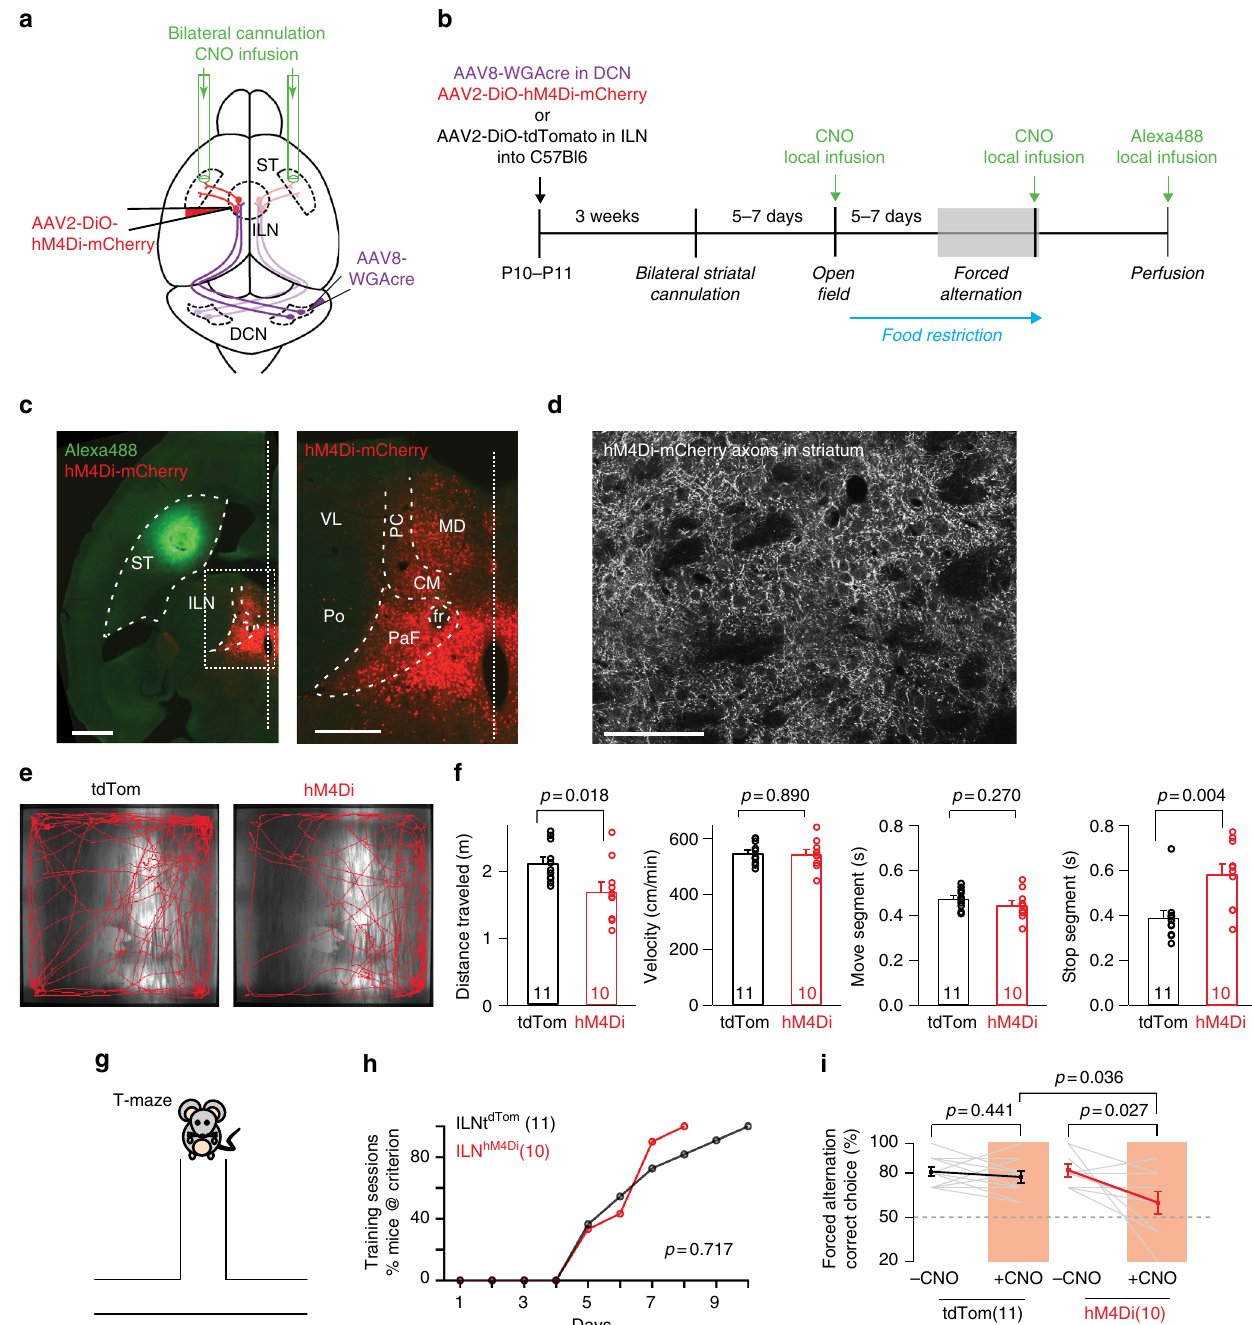
Fig. 7 Striatum-speci fi c silencing of cerebello-striatal connectivity. a Stereotaxic injection scheme for local silencing experiments. For local infusion of CNO, mice are bilaterally cannulated in the dorsal striatum. b Timeline and analysis scheme of local silencing experiments. See text and methods for details. c Overview (left) and ILN enlargement (right) of dorsal striatum and thalamic nuclei in mice at the end of the experiment. Cells expressing hM4Di- mCherry fusion protein (red) are observed in parafascicular nucleus (PaF) and centromedial nucleus (CM). The spread of Alexa488 dextran applied through the cannula in the striatum is shown in green ( N = 11 mice). d High magni fi cation image of hM4Di-mCherry positive axons in the dorsal striatum. This reveals ef fi cient transport of the hM4Di-mCherry fusion protein into the thalamo-striatal axons. e Example open fi eld tracks of control ILN tdTom (tdTom) and ILN hM4Di (hM4Di) expressing mice (targeted with intersectional viral approach described above). Mice were locally infused with CNO (30 μ M, 800 nl/side) 35 min before the test. f Quanti fi cation of distance traveled in open fi eld, velocity, move segments, and stop segments of control ILN tdTom and ILN hM4Di mice (intersectional viral approach described above, N = 11 and 10 mice, respectively; mean ± SEM, unpaired t -test for open fi eld, velocity and move segments. For stop segments, Mann-Whitney test, two-tailed). g T-maze forced alternation. h Mice were trained in a forced alternation paradigm with food reward. The percentage of mice reaching the training criterion after each day is plotted. ILN tdTom (tdTom) and ILN hM4Di (hM4Di) mice (intersectional viral approach described above, N = 11 and 10 mice,